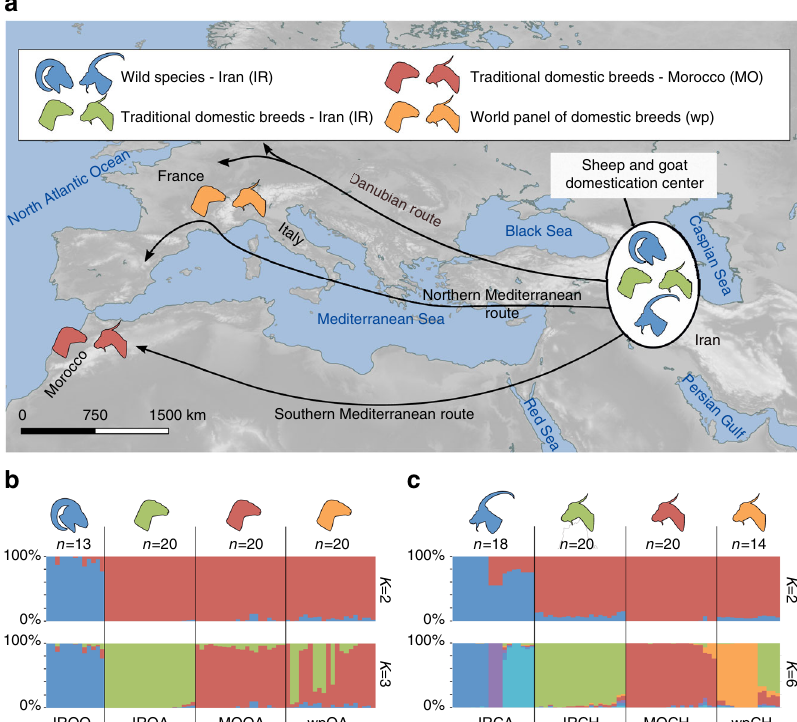
Fig. 1 Sampling with regard to the domestication center and main colonizations routes. a Sampling locations represented by the animal ’ s silhouettes. The domestication center and the main colonization routes (Northern and Southern Mediterranean routes and Danubian route) are presented. Proportion of genomes assigned to K genetic clusters for Ovis ( K = 2 and K = 3) ( b ) and Capra ( K = 2 and K = 6) ( c ) individuals. The number of sampled individuals ( n ) is